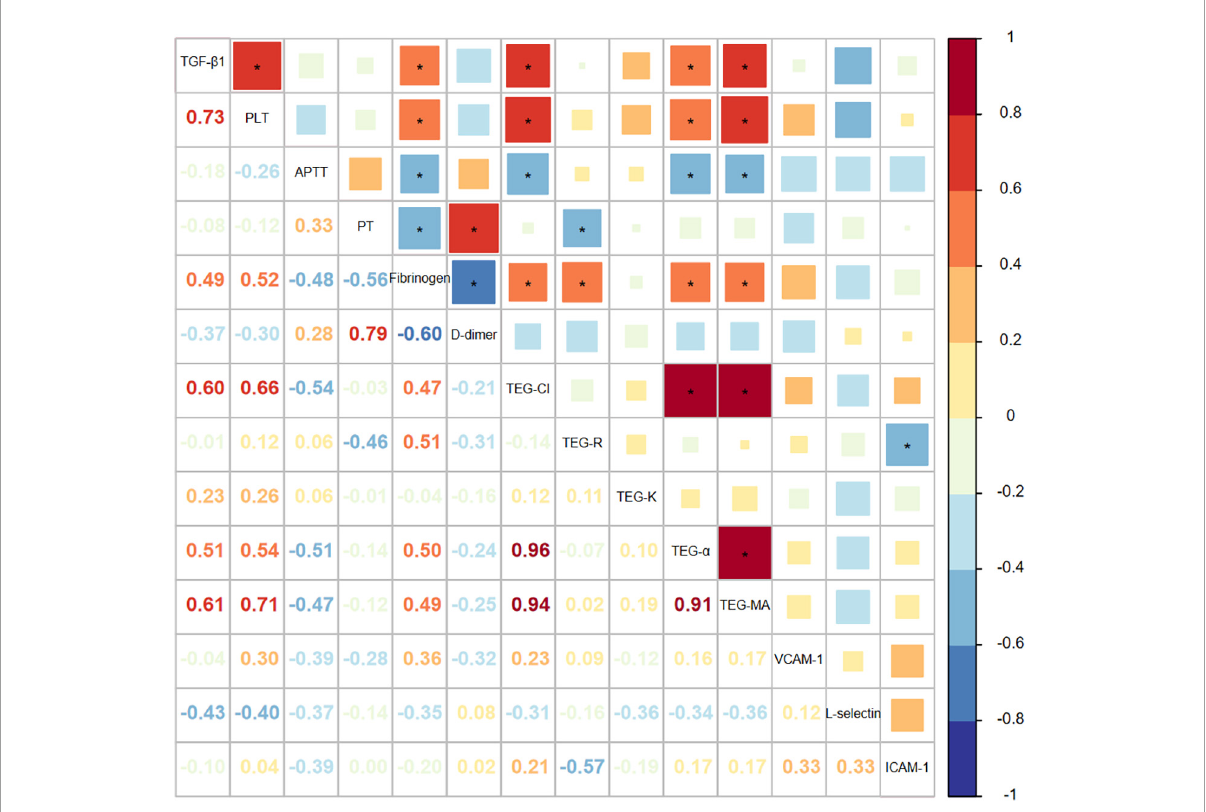
FIGURE1 The correlation between TGF- β 1 and factors associated with coagulation and endothelial dysfunction in portal vein thrombosis (PVT)